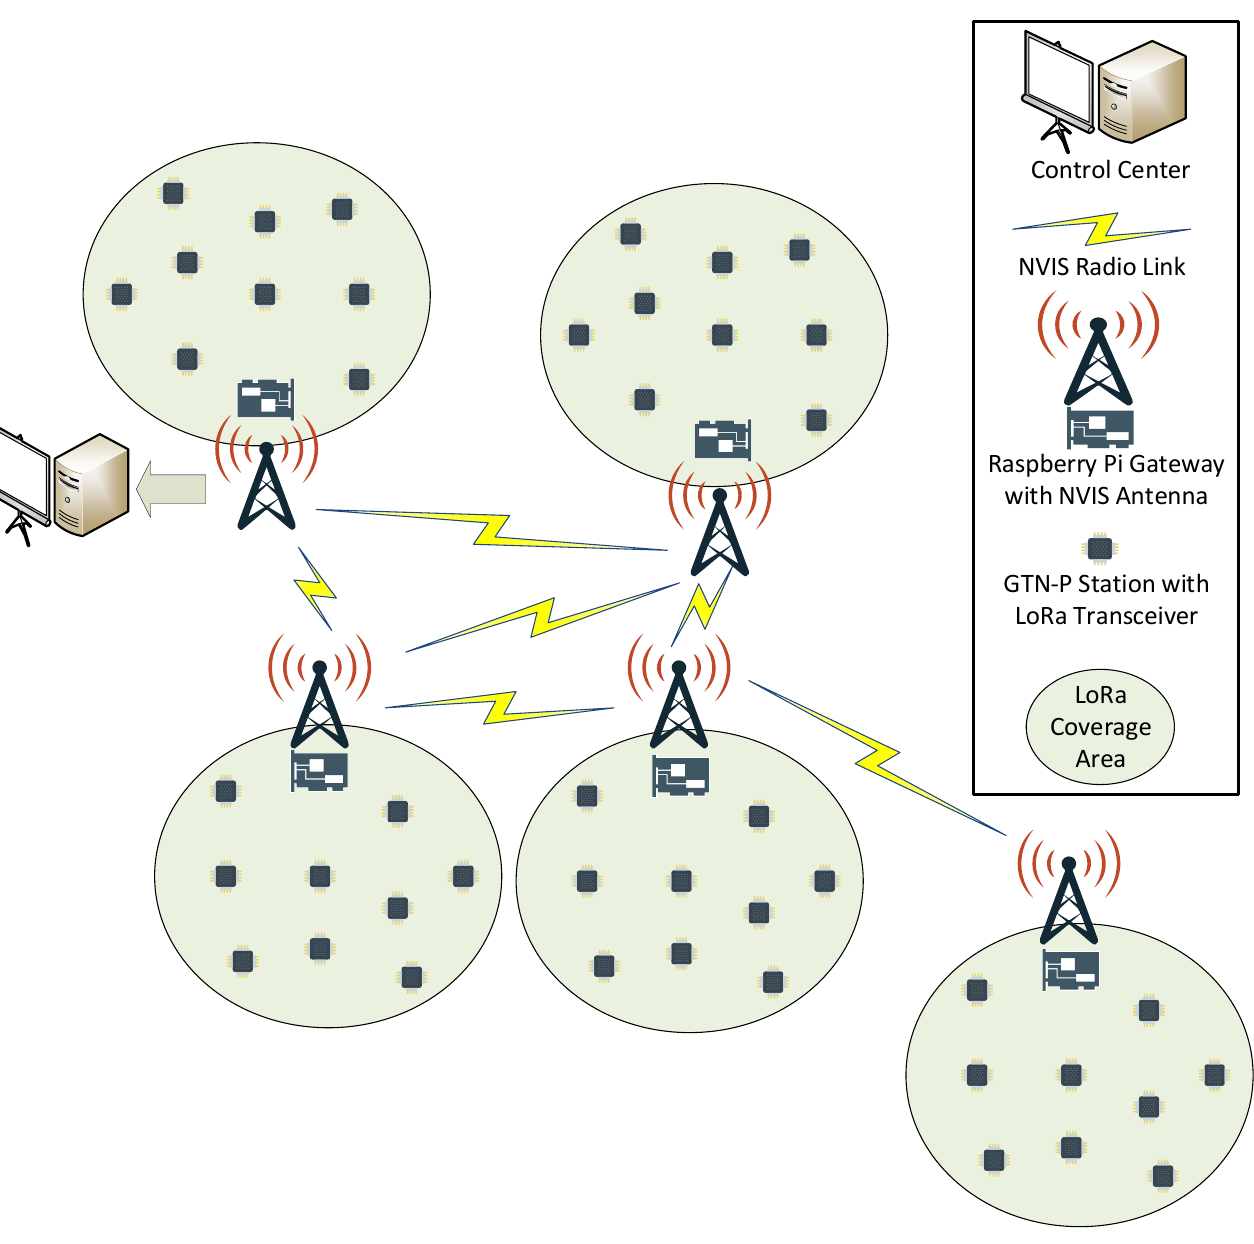
Figure 1. Network diagram of the SHETLAND-NET project telemetry service.